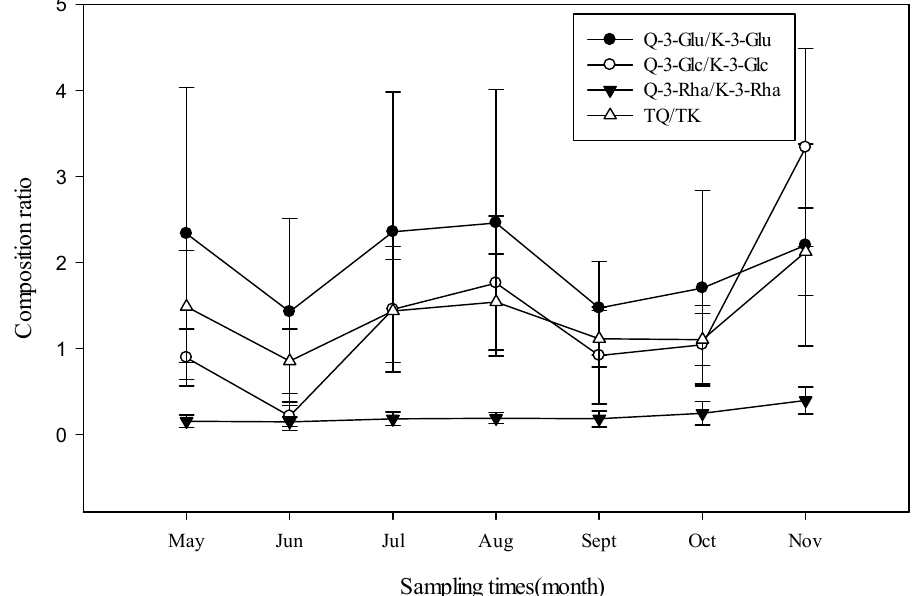
Figure 5. Seasonal variation in ratios of quercetin glycosides to kaempferol glycosides for the leaves of C. paliurus. The meaning of Q-3-Glu, Q-3-Glc, Q-3-Rha, K-3-Glu, K-3-Glc, K-3-Rha, TQ, and TK is the same as Figure 3. Each value presented is the mean of 10 families.